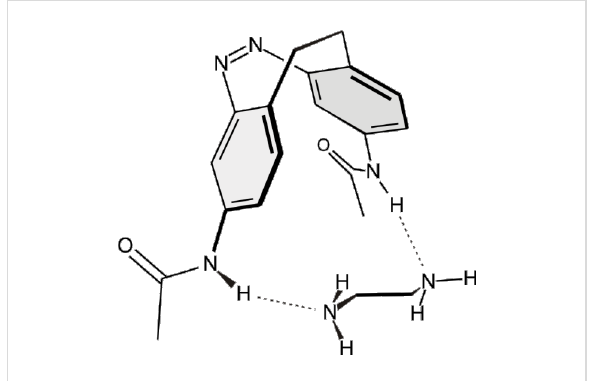
Figure 5: DFT-calculated structure (B3LYP/6-31+G**) of a complex of 5 with ethylenediamine as a conceivable model of the binding mode of 3,3’-diacetamido-EBAB 5